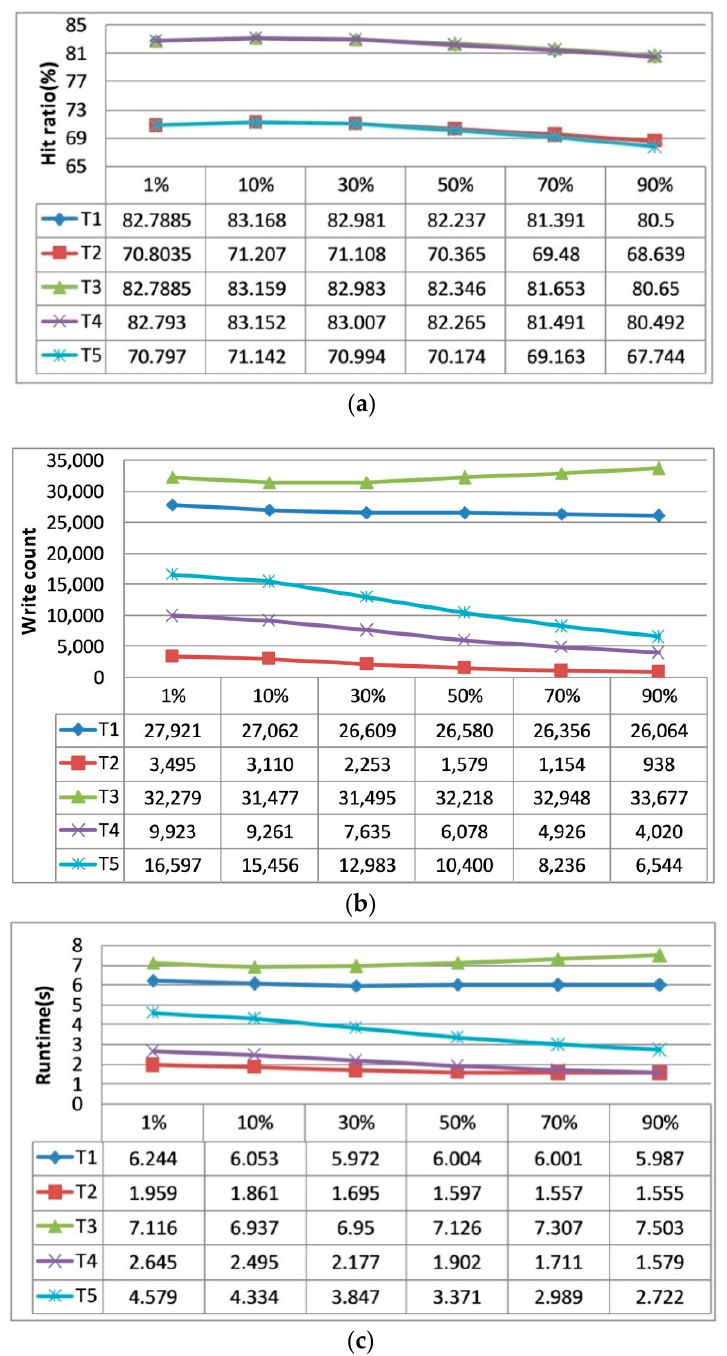
Figure 6. ( a ) Hit ratio, ( b ) write count and ( c ) total runtime curves under different L (cid:2918)(cid:2919)(cid:2928) values in